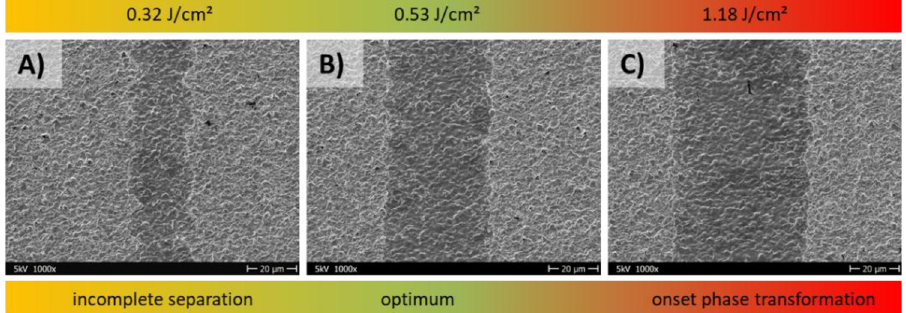
Fig. 5. Comparison of SEM images of iso-cut scribe lines patterned with three characteristic fl uences: (A) 0.28J/cm 2 (incomplete separation), (B) 0.53J/cm 2 (optimal scribe line properties), and (C) 1.18 J/cm 2 (onset of transforming the CIGSe absorber into a conductive phase). The color bars indicate the respective patterning regimes and the chosen patterning fl uences. The magni fi cation of the images is 1000 (cid:1) , the excitation voltage is